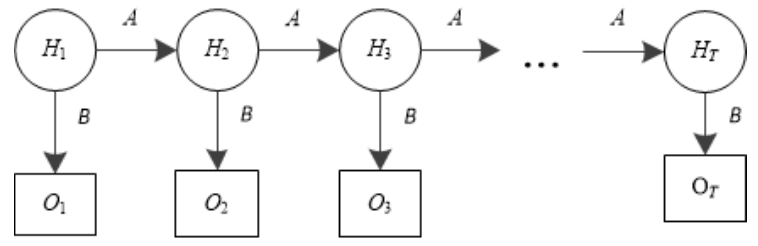
Figure 1. The state diagram of the Hidden Markov model.